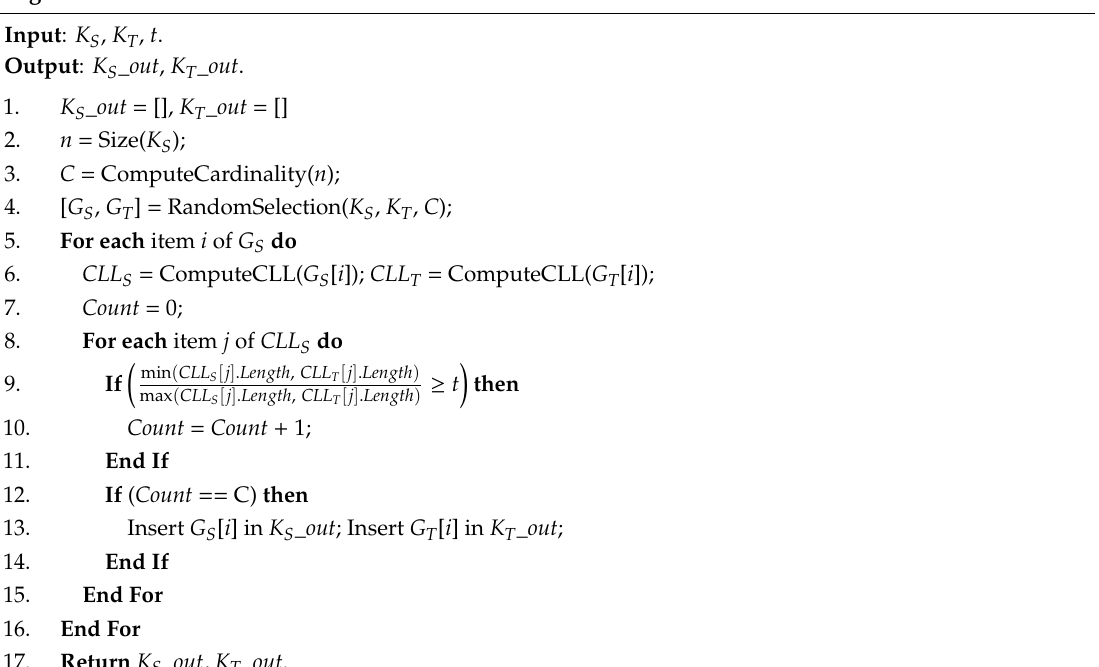
Algorithm 1 Geometric invariance